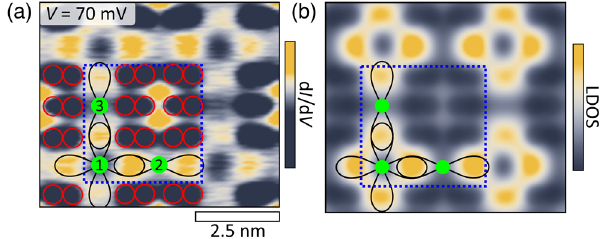
FIG. 2. (a) Differential-conductance map above a symmetric Lieb-like lattice acquired at V ¼ 70 mV, shown for part of the lattice (see SM [40] for entire lattice). The CO molecules are encircled in red and p x - and p y -like orbitals (black) are indicated in one unit cell (blue dashed box). The map was acquired after ¼ 1 nA, V ¼ 70 mV, with a bias modula- stabilization at I set set ¼ 10 mV. (b) LDOS map for the same energy tion V rms simulated using the muffin-tin model.